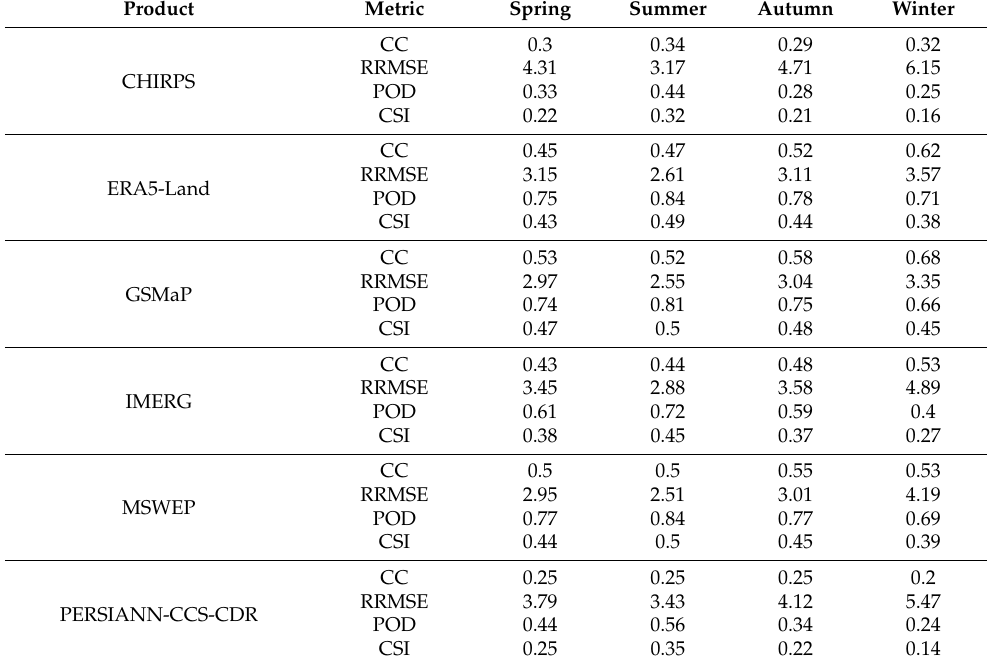
Table 3. Mean values of CC, RRMSE, POD and CSI for different seasons between 2015 and 2019.